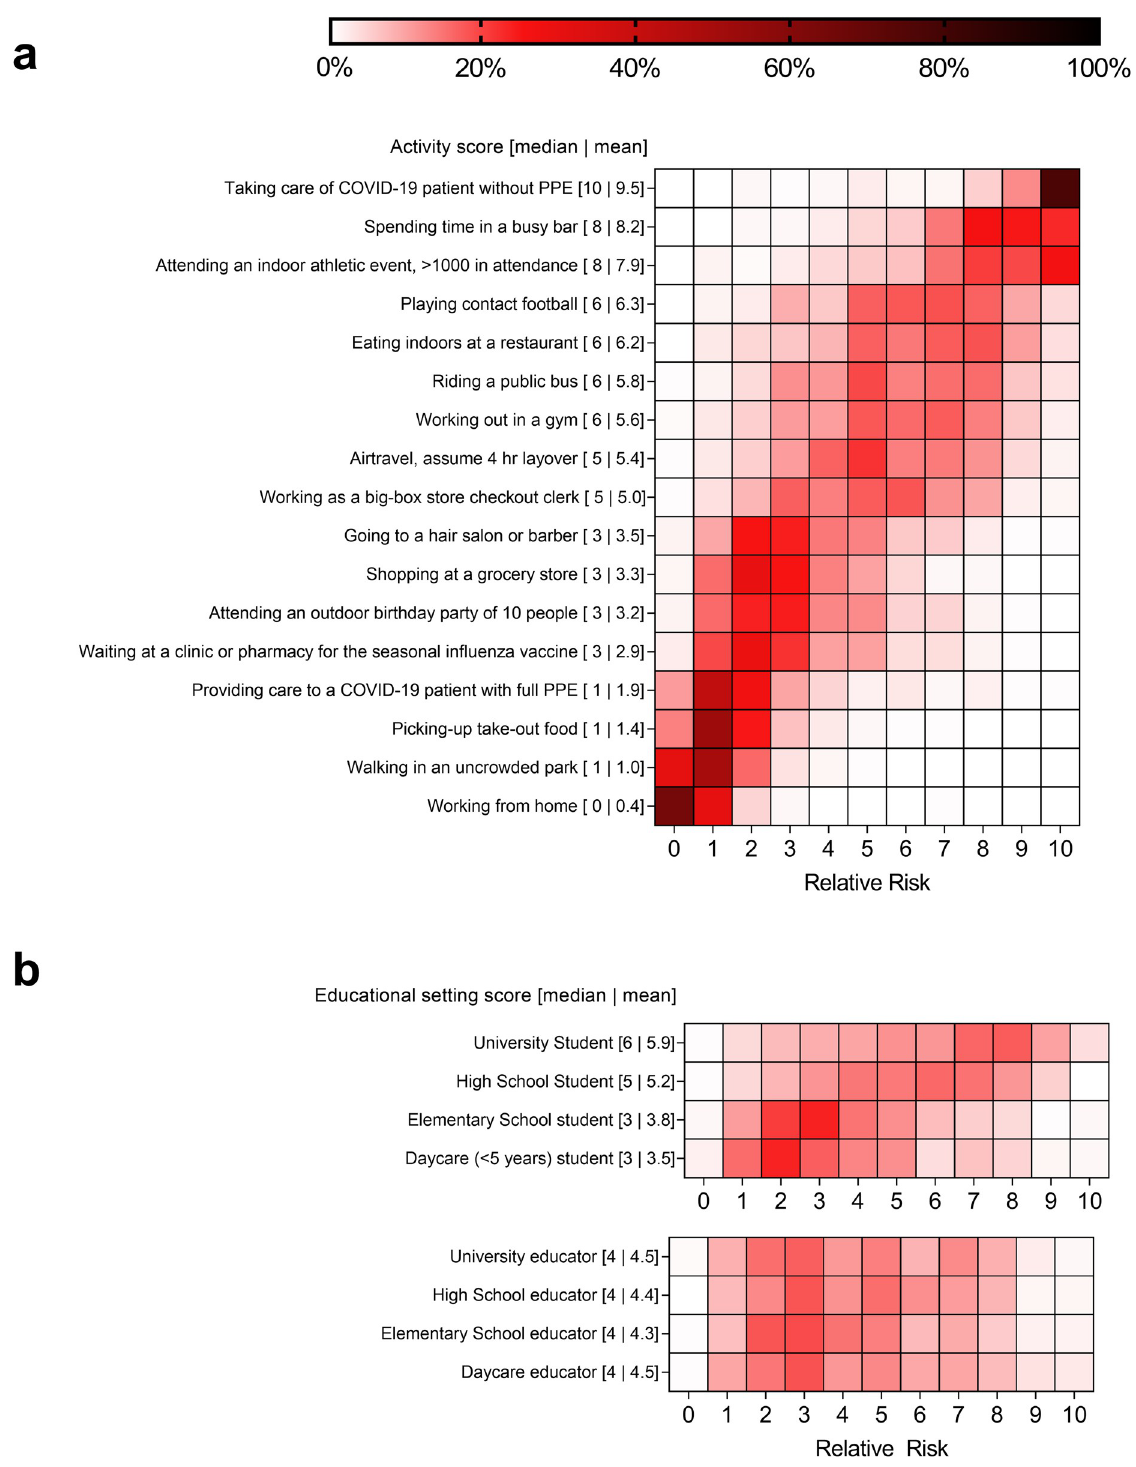
Fig 1. Heatmap of respondents risk assessment score. (a) social activities (b) educational setting. The frequency of responses for each score is represented by a percentage of the overall number of responses.